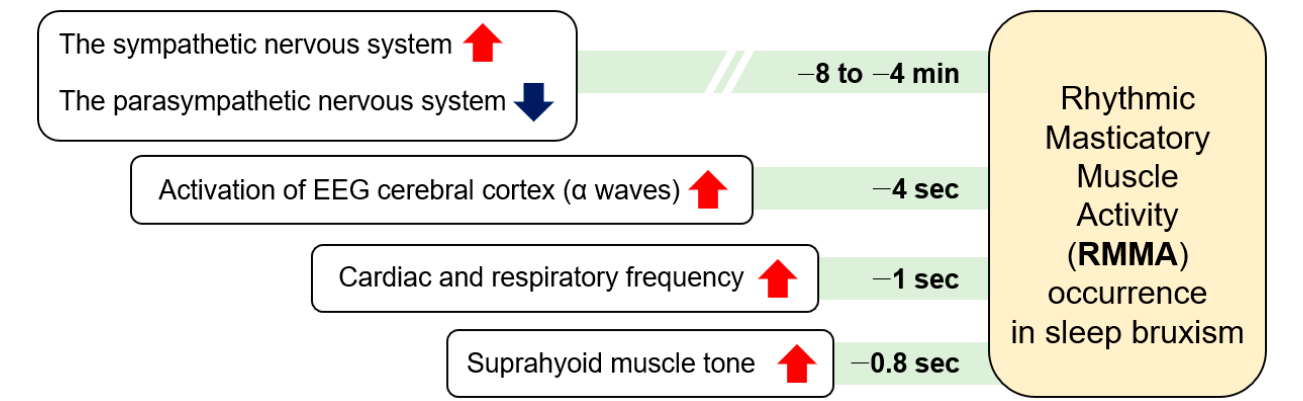
Figure 2. The serial occurrence of rhythmic masticatory muscle activity and sleep bruxism.